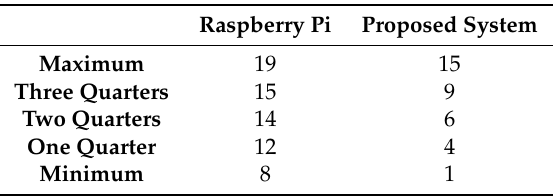
Table 7. Representative